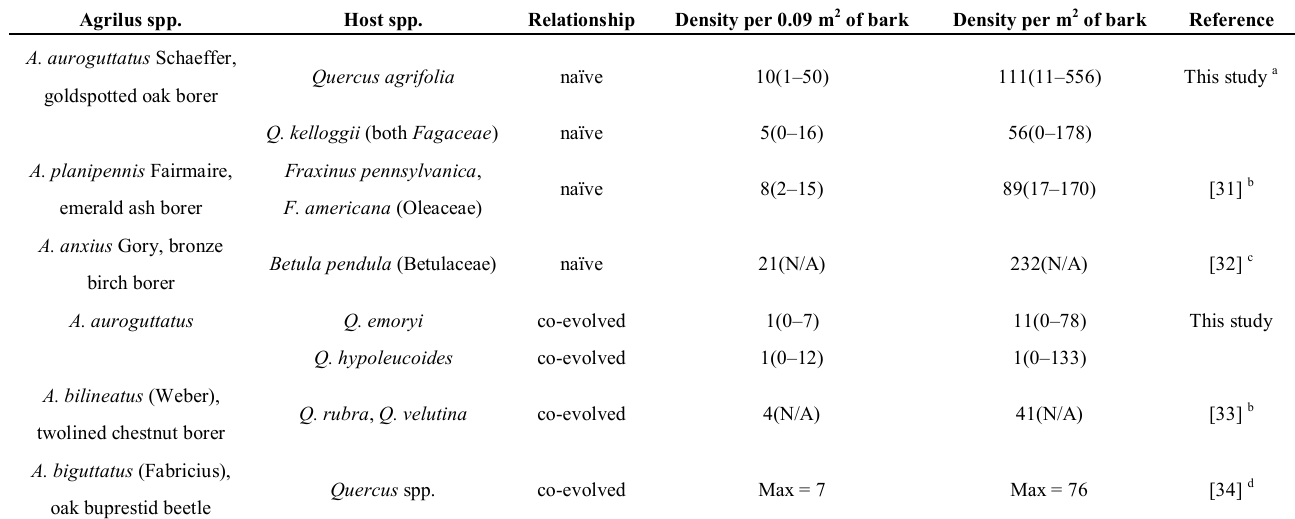
Table 2. Mean (range) emergence hole density of Agrilus spp. on co-evolved and naïve host trees reported from the literature and this